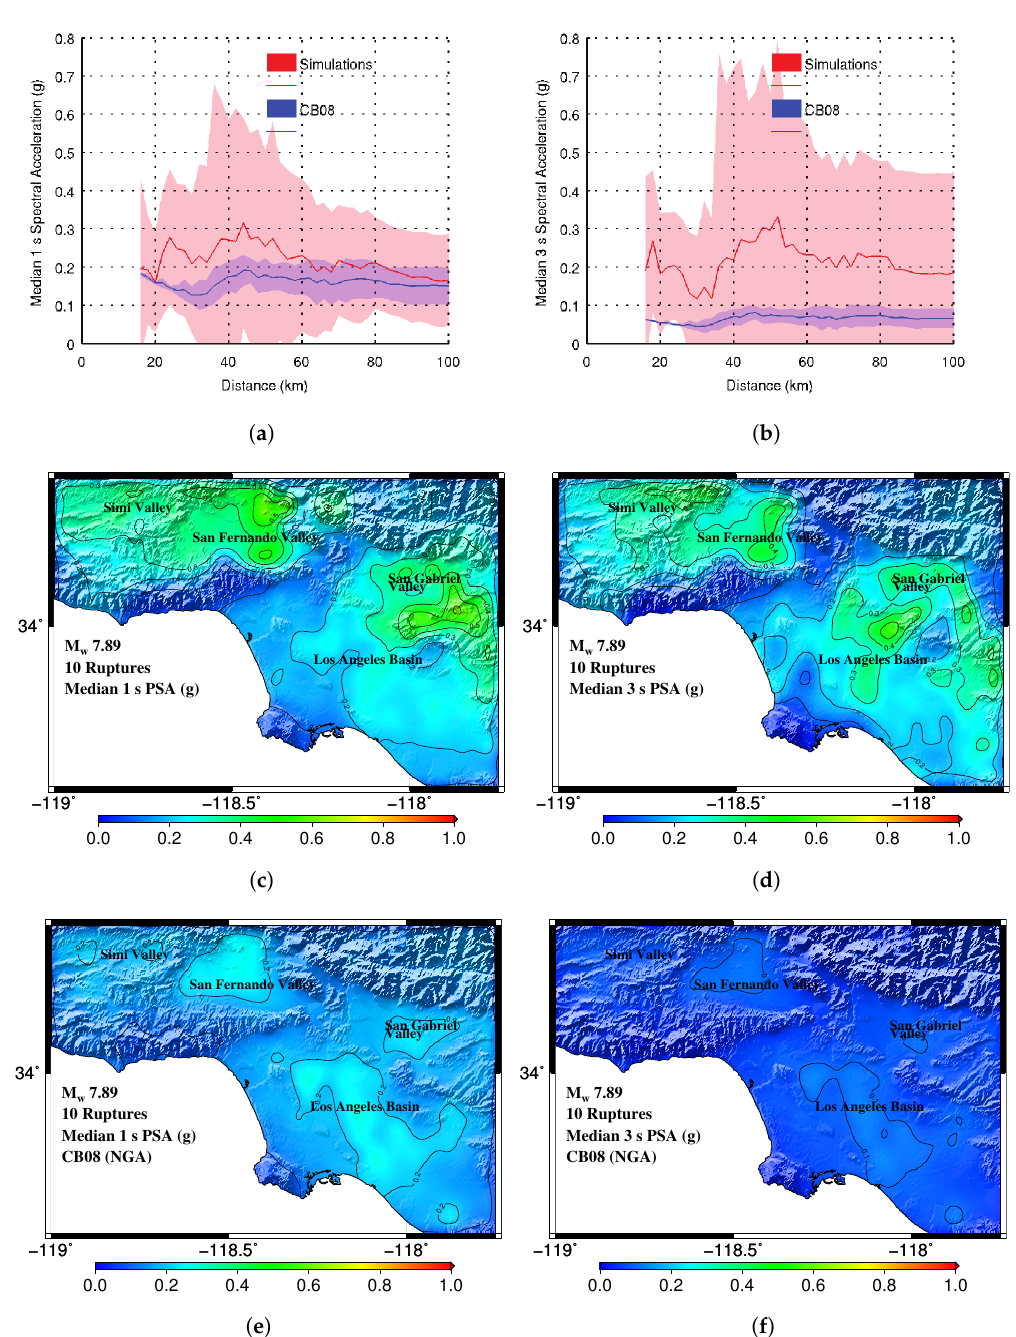
Figure 8. Predictions of spectral accelerations at 1 s and 3 s periods for the ten M w 7.89 scenario earthquakes (five locations and two rupture directions) by simulations and the CB-08 Next Generation Attenuation (NGA) relations. ( a , b ) Median values as a function of the Joyner-Boore source-to-site distance; ( c , d ) Median S a maps from simulations; ( e , f ) Median S a maps from CB-08 NGA